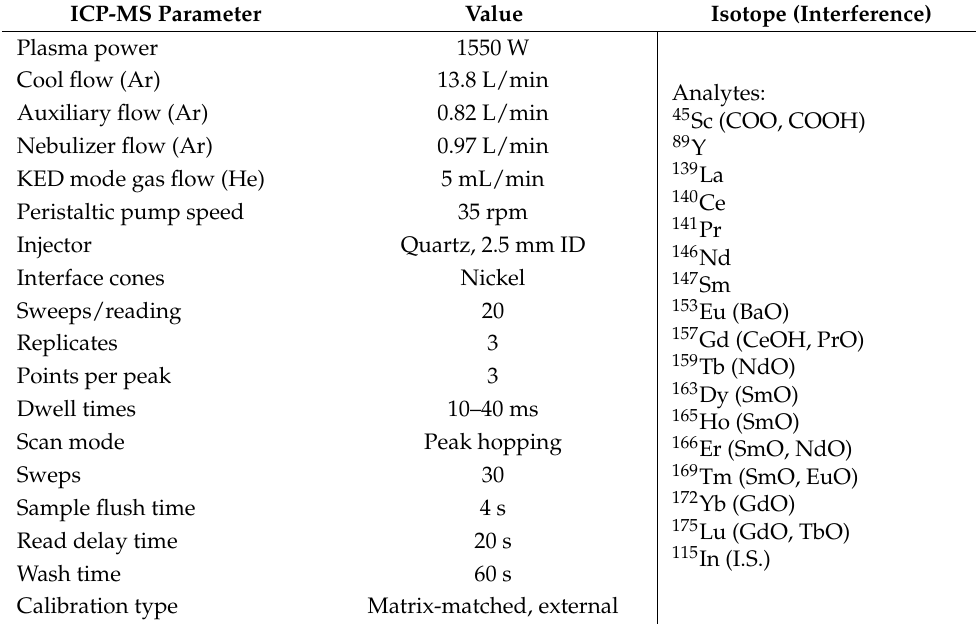
Table 2. ICP-MS instrument setup and isotopes (interference) of each